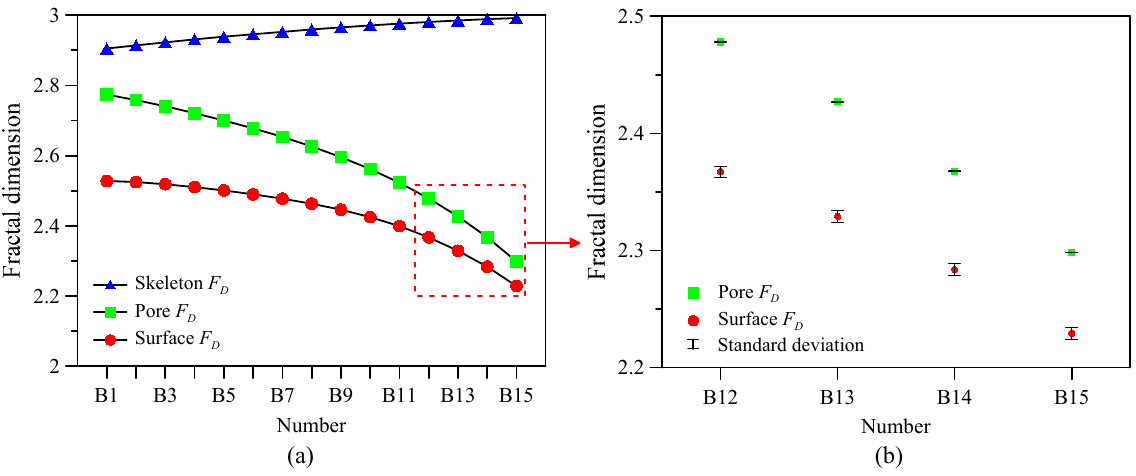
Figure 7. Fractal dimension evolution of compaction model. ( a ) Three kinds of fractal phases; ( b ) Magnification of fractal dimension and standard deviation of some sub-models.